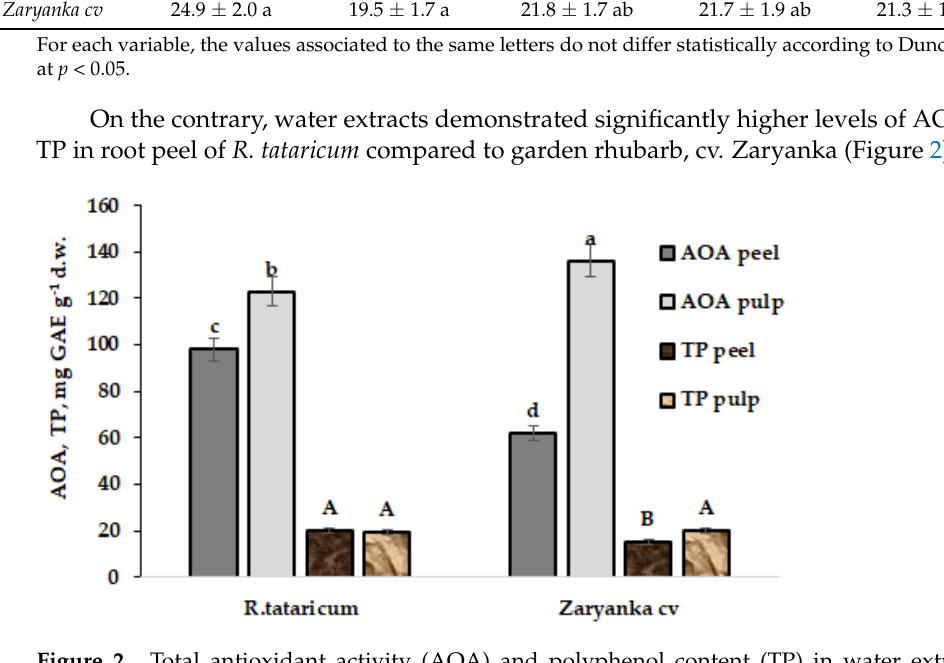
Figure 2. Total antioxidant activity (AOA) and polyphenol content (TP) in water extracts of R. tataricum roots peel/pulp and garden rhubarb cv. Zaryanka. The values with the same letters do not differ statistically according to Duncan’s test at p < 0.05.